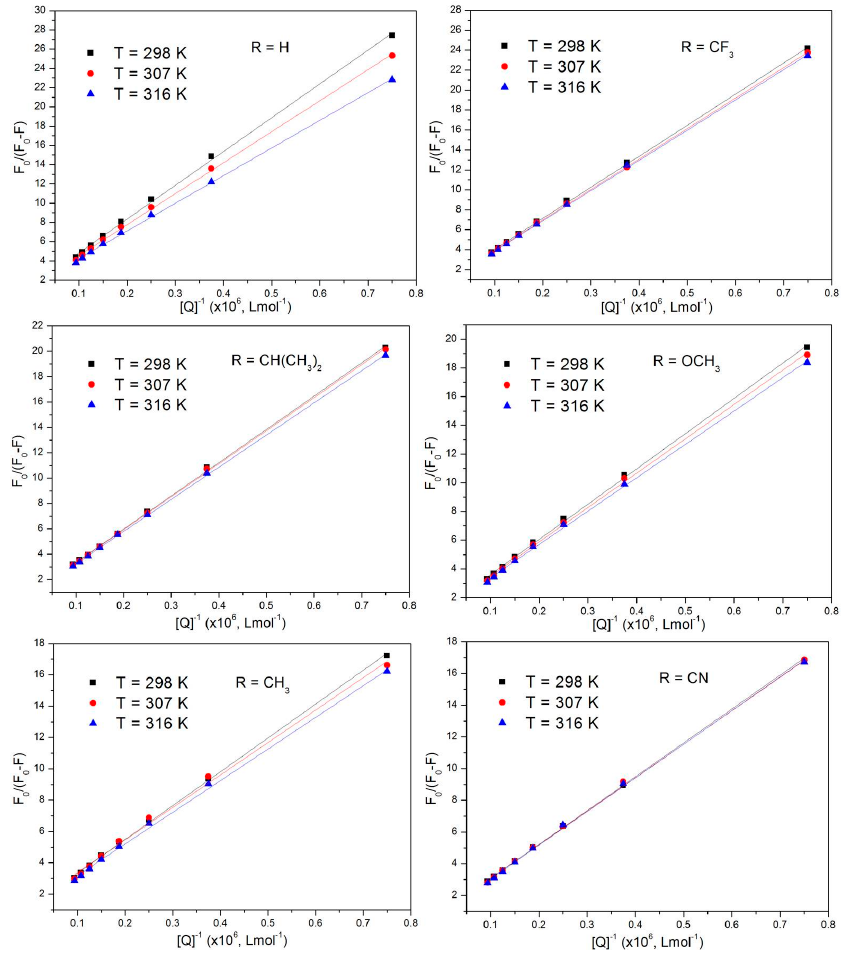
Figure 4 . Modified Stern-Volmer plots of PDQL-HSA systems. Figure 4. Modified Stern-Volmer plots of PDQL-HSA